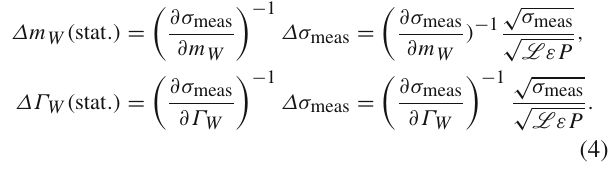
3 Consideration on the